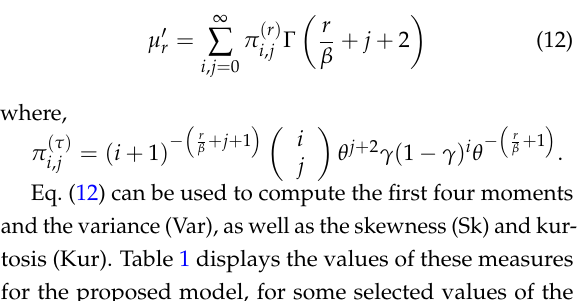
Fig. 1. The MOPA density function plots.